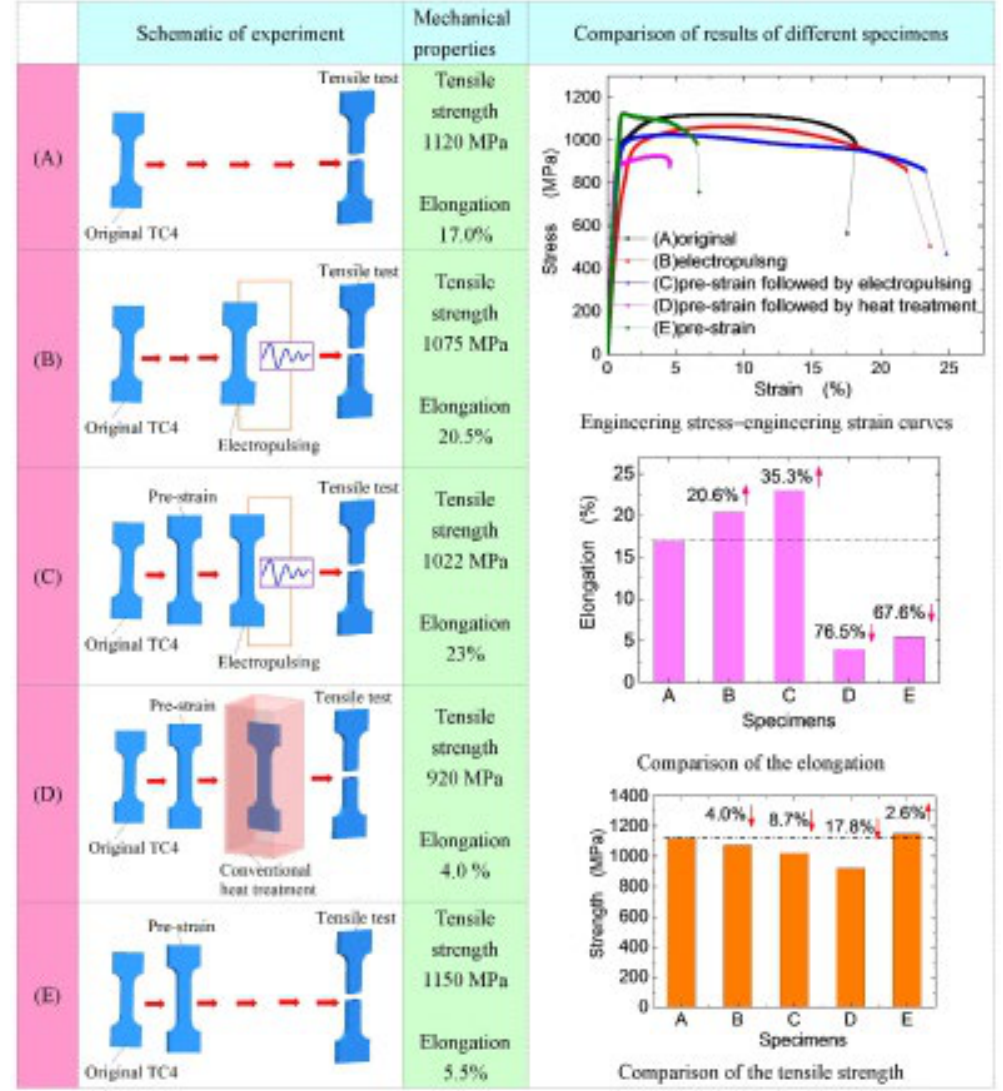
Figure 8. Schematic of the experiment conditions and comparison of the